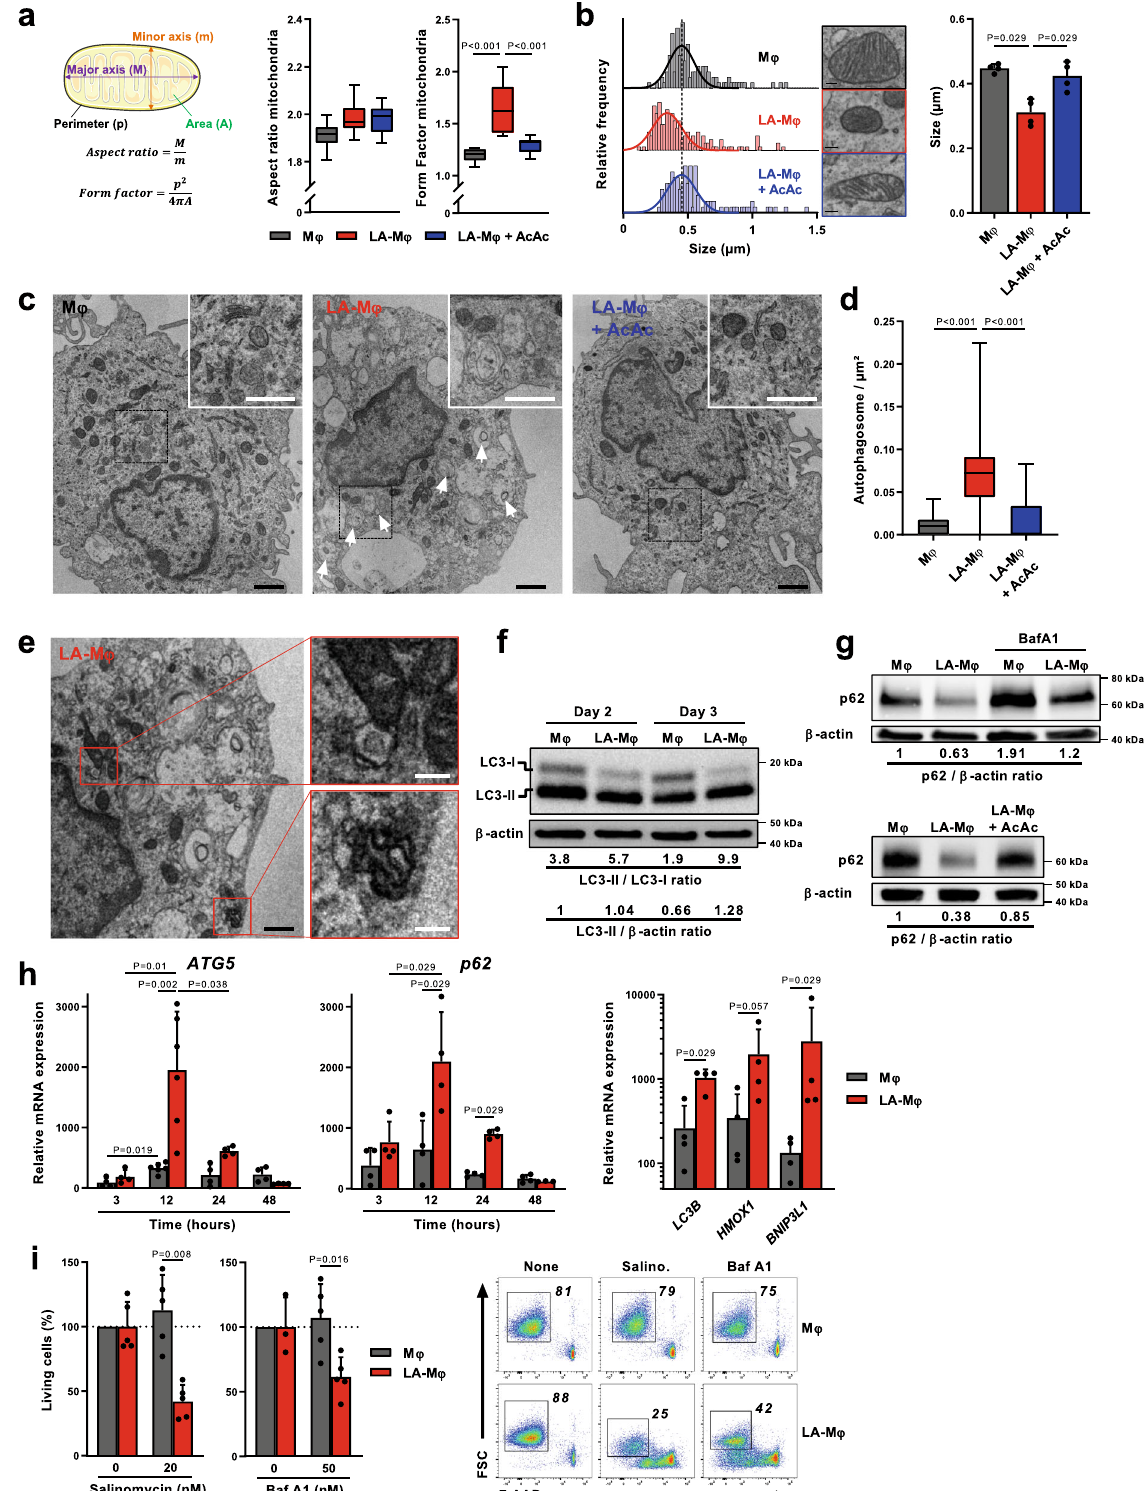
GM-CSF displayed a discrete increase in ATG5 and p62 mRNA levels (Fig. 2h). In conclusion, autophagic fl ux is functional and exacerbated in macrophages under lactic acidosis